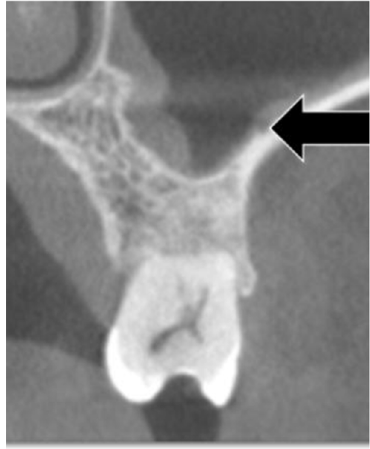
Fig. 2. Below the membrane variety of